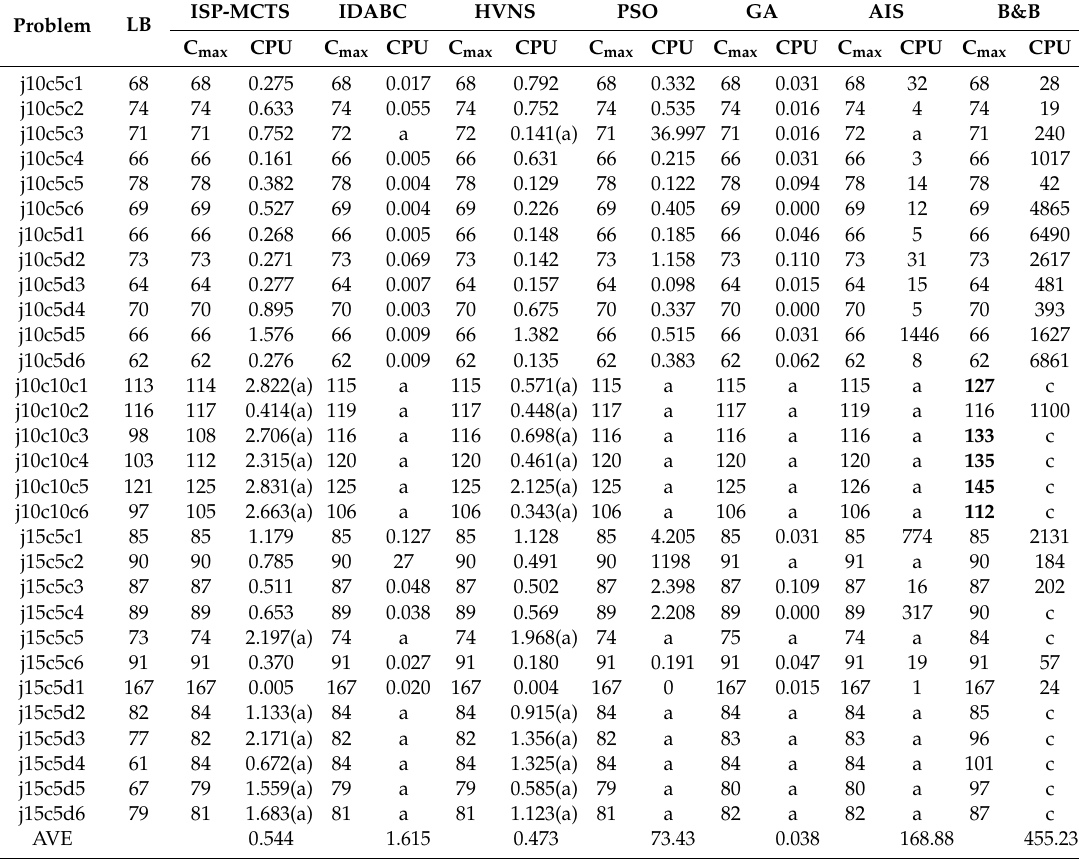
Table 5. Comparison results for type c and d problems.